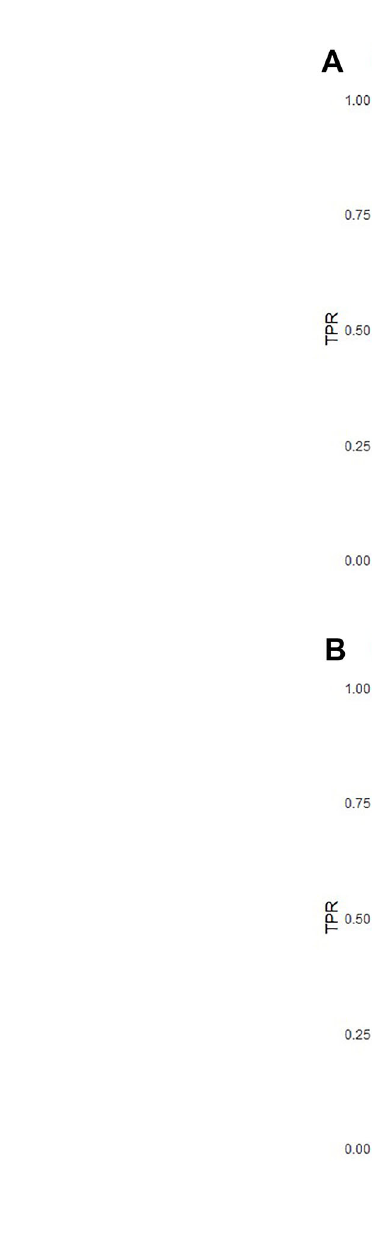
FIGURE 3 | Receiver operating characteristic (ROC) curve featuring model performance evaluation as an area under the curve (AUC), sensitivity TPR and FPR or (1- speci fi city) for (A) the CT prediction model 3 and (B) a logistic regression model of the test data set. The CT model (A) featured an AUC of 0.6650, a sensitivity of 0.6850, and a speci fi city of 0.5114, The logistic regression model (B) achieved a slightly lower AUC of 0.6357 with a sensitivity of 0.6337 and speci fi city of